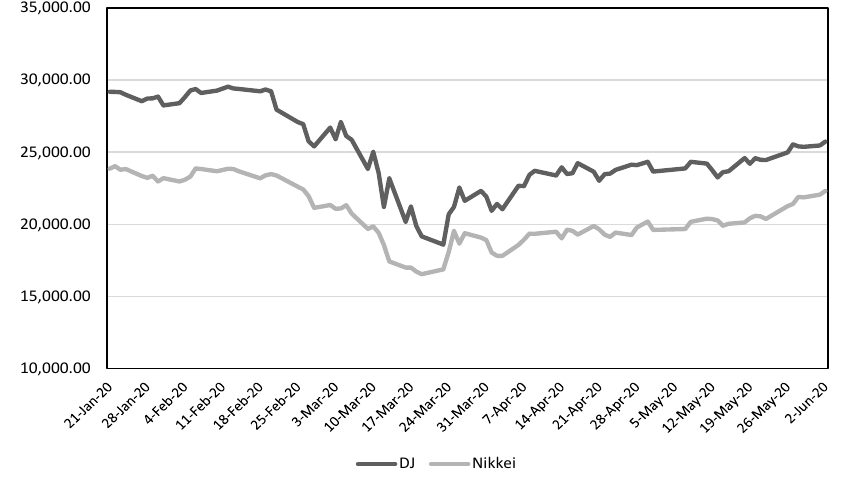
DJ Figure 1. Dow Jones (DJ), Nikkei 225 (Nikkei) indices between 21 January 2020 and 4 June 2020. The data Figure 1. Dow Jones (DJ), Nikkei 225 (Nikkei) indices between 21 January 2020 and 4 June 2020. The for the DJ and Nikkei are retrieved from the homepage of ADVFN and Nikkei, Inc., respectively. data for the DJ and Nikkei are retrieved from the homepage of ADVFN and Nikkei, Inc., respectively. 10,000.00 At the same time, global lockdown resulted in layoffs in the labor market. In the US, the unemployment rate sky-rocketed after the lockdown restrictions due to the high labor market flexibility. A huge mid-March unemployment increase was reflected in increases in the number of initial unemployment insurance claims per week in the United States (Figure 2). Figure 1. Dow Jones (DJ), Nikkei 225 (Nikkei) indices between 21 January 2020 and 4 June 2020. The data for the DJ and Nikkei are retrieved from the homepage of ADVFN and Nikkei, Inc., respectively.